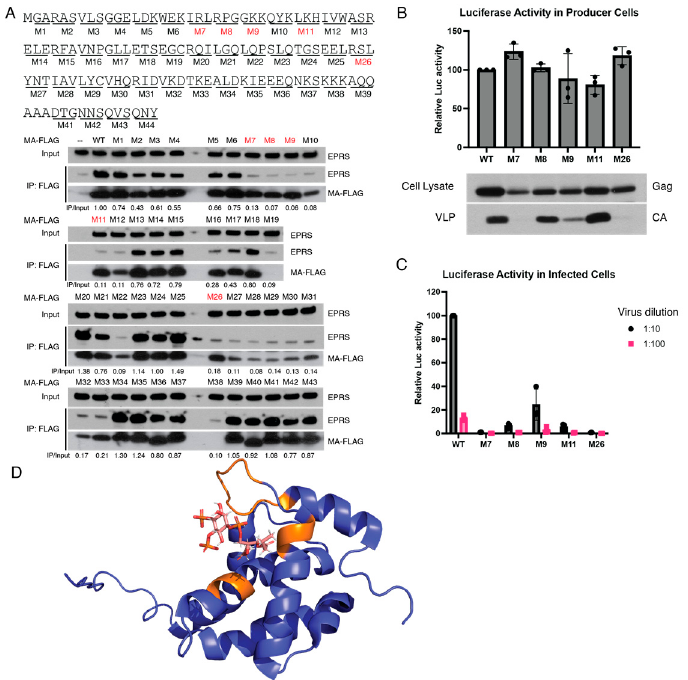
Figure 5. Identification of MA residues critical for interaction with EPRS. ( A ) Alanine-scanning mutagenesis screen to identify interaction-ablative MA mutants. MA residues were mutated to alanine in groups of three. A total of 43 mutants were generated and tested for EPRS interaction via co-IP. Five mutants with robust MA expression but significantly reduced EPRS interaction are indicated with red boxes. EPRS IP/input ratio (normalized to WT) is labeled below each lane. Mutations of interest were selected based on two criteria: (1) low IP/input ratio; (2) MA-FLAG expression is comparable to WT. ( B ) Production of progeny virions by MA mutants as measured via luciferase activity in producer cells ( top ). Gag expression in producer cells and HIV-1 CA in supernatants as assessed by immunoblotting ( bottom ). The top of the bars represents mean value of 3 trials. ( C ) Relative infectivity of virion-containing supernatants measured by luciferase activity in target cells. The top of the bars represents mean value of 3 trials. ( D ) Critical interacting residues (orange) mapped onto a previously reported crystal structure of MA binding to PI(4,5)P 2 (PDB: 2H3Z)